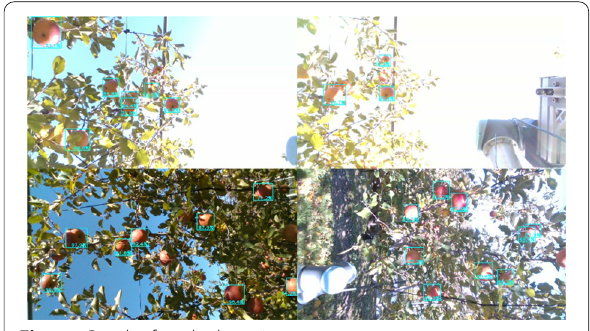
Fig. 14 Result of apple